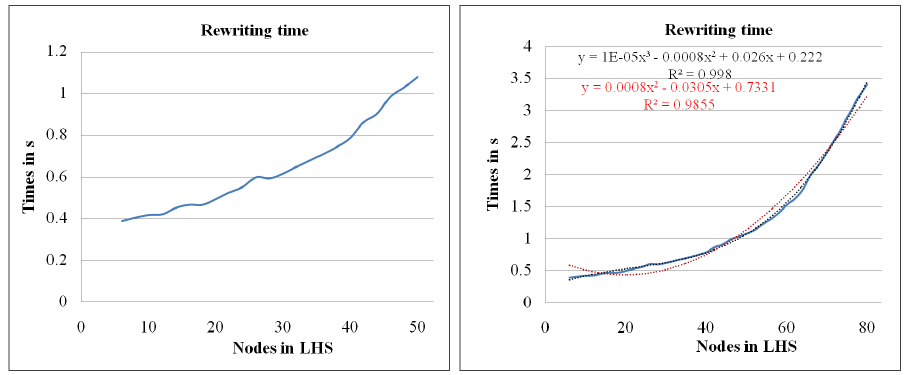
Figure 12. Analysis of the GRR size.